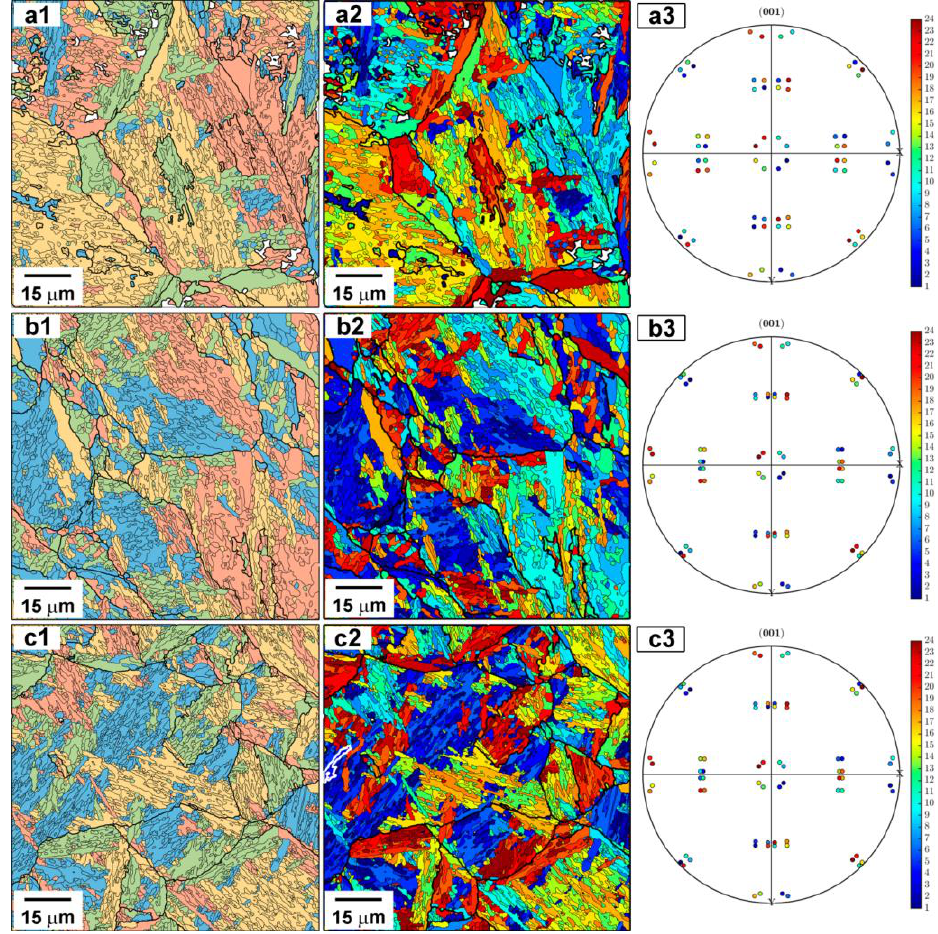
Figure 6. EBSD analysis of the steel subjected to Q&P processing with quenching in a salt bath at temperatures of 160 °C ( a1–a3 ), 200 °C ( b1–b3 ), and 250 °C ( c1–c3 ): (column 1) misorientation map showing HABs of the reconstructed austenite grains and packets; (column 2) identification of packets in PAGs; (column 3) {001} pole figure showings (0 0 1)[1 0 0] orientations that maintain the K–S orientation relationship.